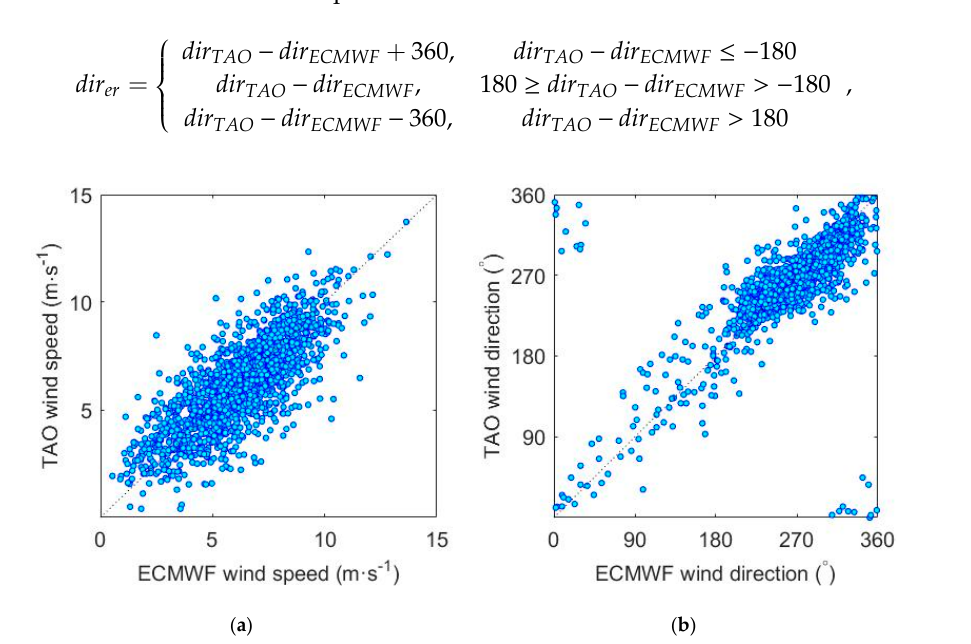
Figure 1. Scatter plots of TAO and ECMWF paired data. ( a ) Scatter plots of wind speed; ( b ) Scatter plots of wind direction. The dashed line in this figure is the diagonal line.